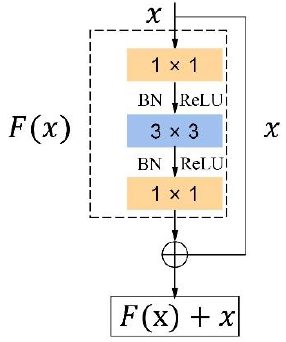
Figure 2. Residual